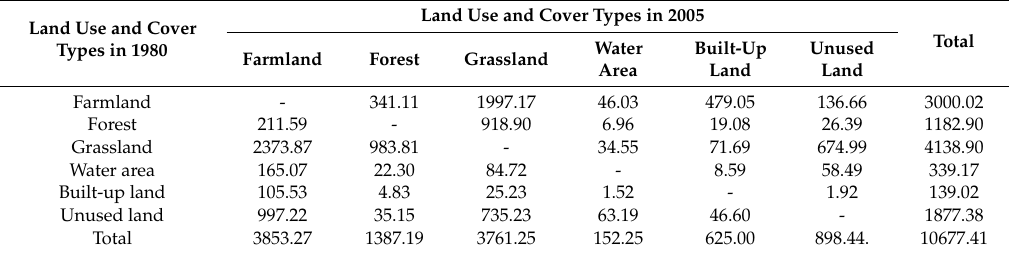
Table 3. Land use and cover conversion matrix from 1980 to 2005 (km 2